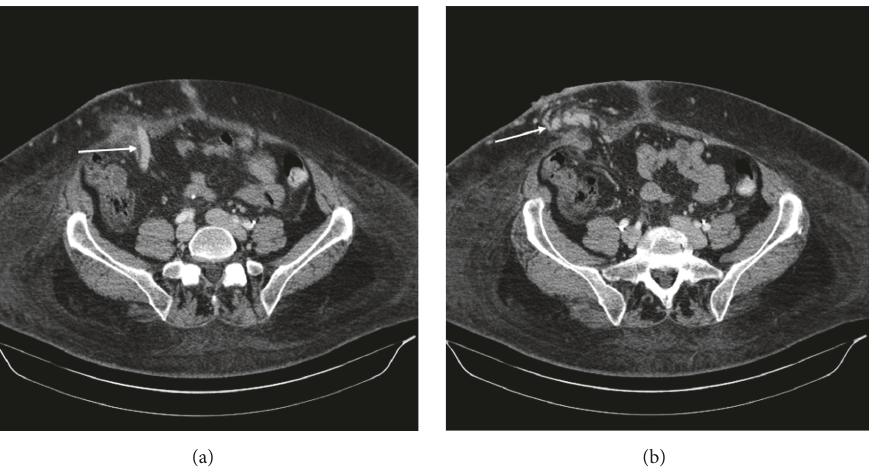
Figure 1: IV contrast-enhanced CT images of the abdomen and pelvic. (a) Large draining varix from the portal venous system (arrow). (b) Multiple varices within the right lower quadrant stoma